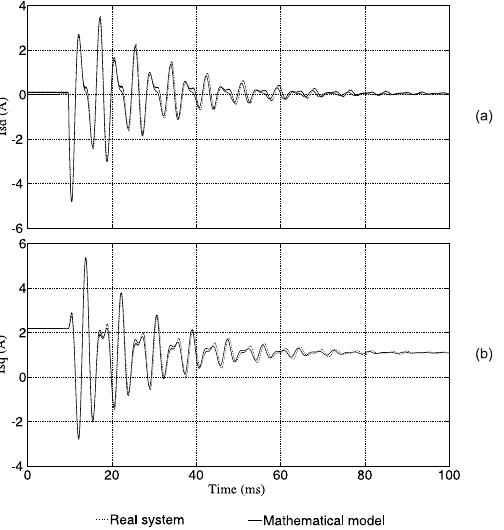
Figure 3. Dynamics of the model obtained in Equation (21) and the real system: ( a ) Current I Sd ; ( b ) Current I Sq